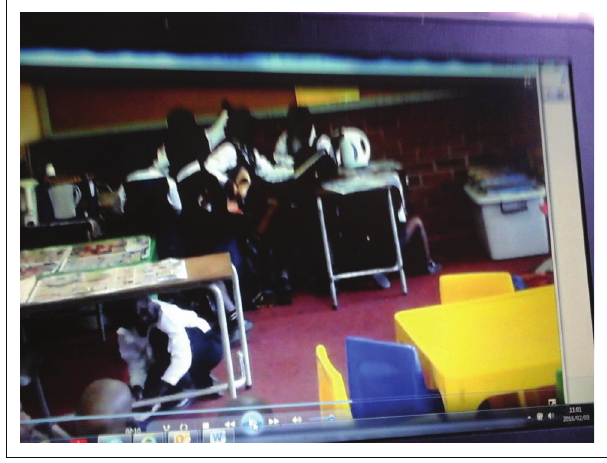
FIGURE 4: Disruptive learners.